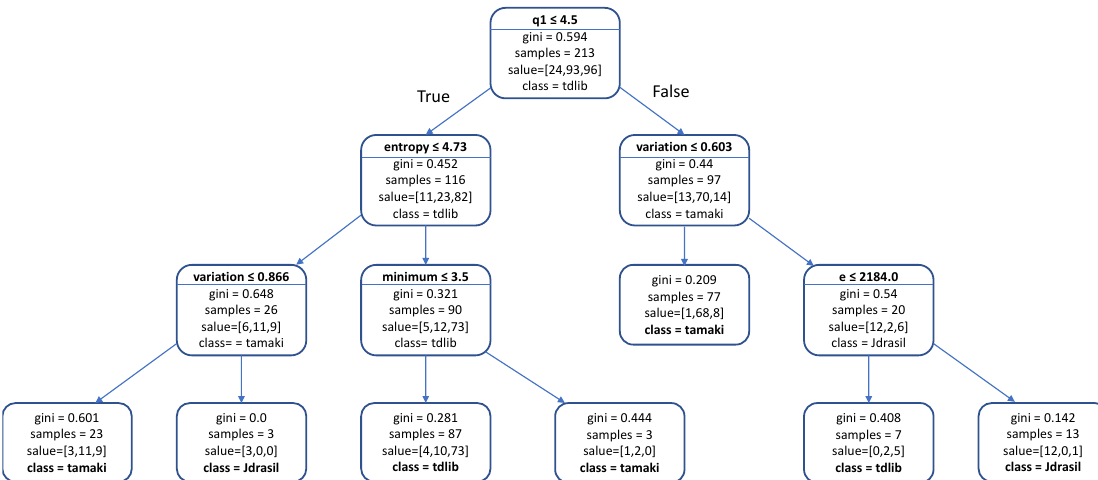
Figure 3. The CART Decision Tree trained on Dataset B. Each rectangle represents a node in the tree. The first line in each internal node indicates the condition according to which that node splits instances. In leaf nodes, this line is omitted, as no split is executed there. Each internal node’s left child pertains to the subset of instances that met the condition, whereas the right child pertains to those that did not meet the condition. The next line describes the node’s Gini impurity, which is the probability that a randomly chosen element from the set would be incorrectly labeled if its label was randomly drawn from the distribution of labels in the subset. The next line shows how many graphs are in the subset that the node represents, while the following line shows how many instances of each class are in that subset, with the three values corresponding to Jdrasil , tamaki and tdlib , respectively. The last line shows the class which is the most represented in the subset, which is also the class that the Decision Tree would assign to all instances in that